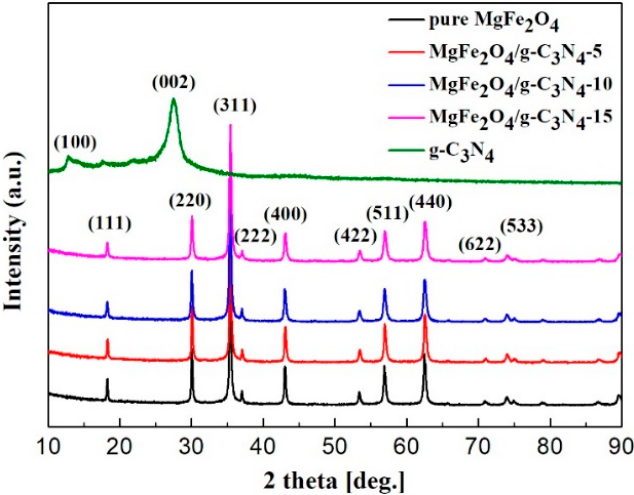
Figure 2. XRD patterns of g-C 3 N 4 , MgFe 2 O 4 porous microspheres and MgFe 2 O 4 /g-C 3 N 4 composites with different g-C 3 N 4 contents.